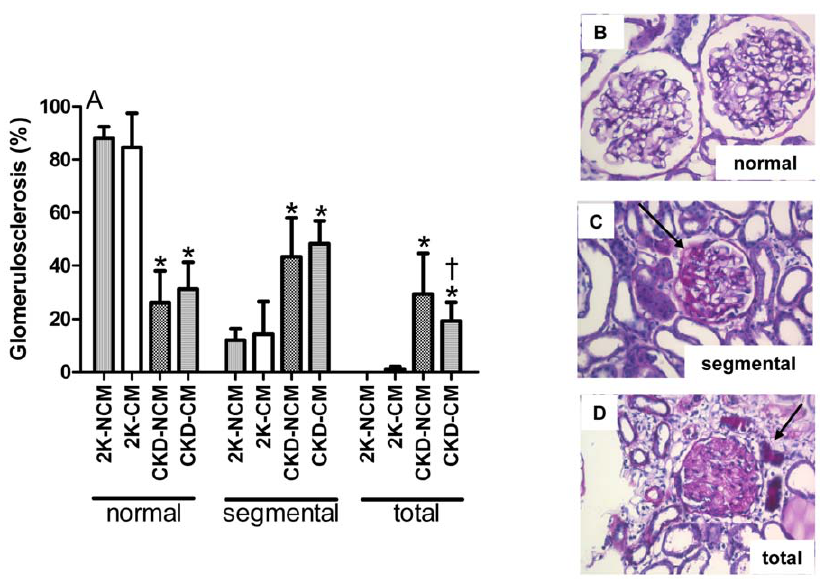
Figure 4. Glomerulosclerosis was reduced by CM treatment. On PAS-stained sections, glomeurosclerosis was reduced after CM treatment (A). Normal (B), segmental (C) and totally sclerotic are shown (D). Black arrows indicate sclerotic areas. 2K-NCM (n=6); 2K-CM (n=6); CKD-NCM (n=13); CKD-CM (n=13). *P , 0.05: CKD vs. 2K, { P , 0.05: CKD-CM vs. CKD-NCM.